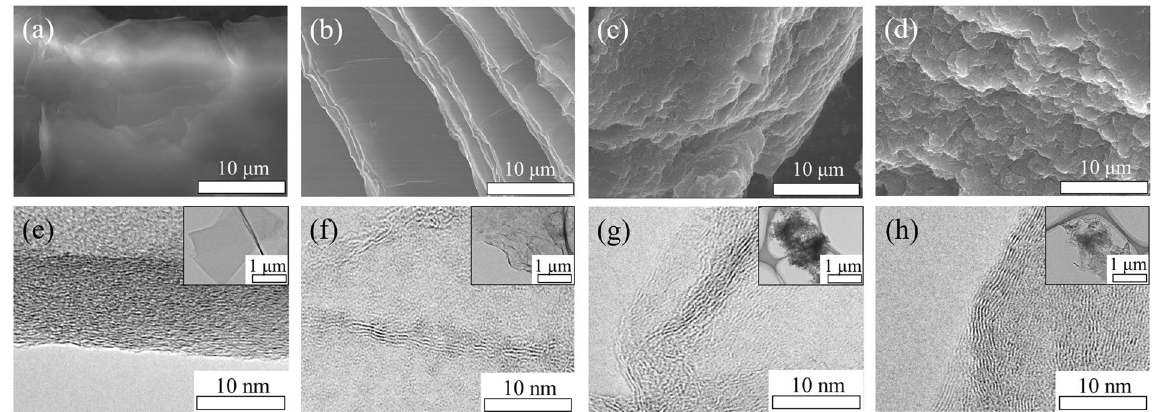
Figure 2. SEM images of ( a ) GO, and its deoxygenated samples treated under ( b ) 1 h, ( c ) 4 h and ( d ) 10 h. The corresponding TEM images are shown in ( e – h ), respectively. The insets of TEM images showing the sheets in low